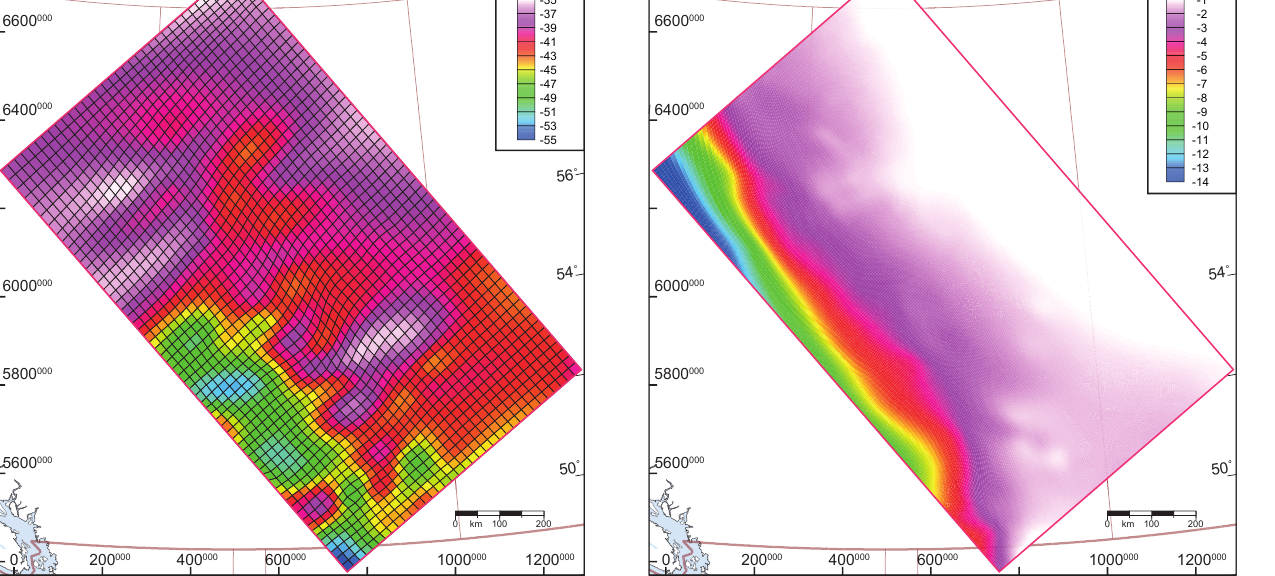
Figure 5. Topography of the Mohoroviˇci´c discontinuity (Moho) within the model box. The map extent is indicated by geographi- cal coordinates (top and right) and by UTM coordinates from zone 11 (left and bottom). The mesh size ( ∼ 20km) at that depth is indi- cated by black lines.